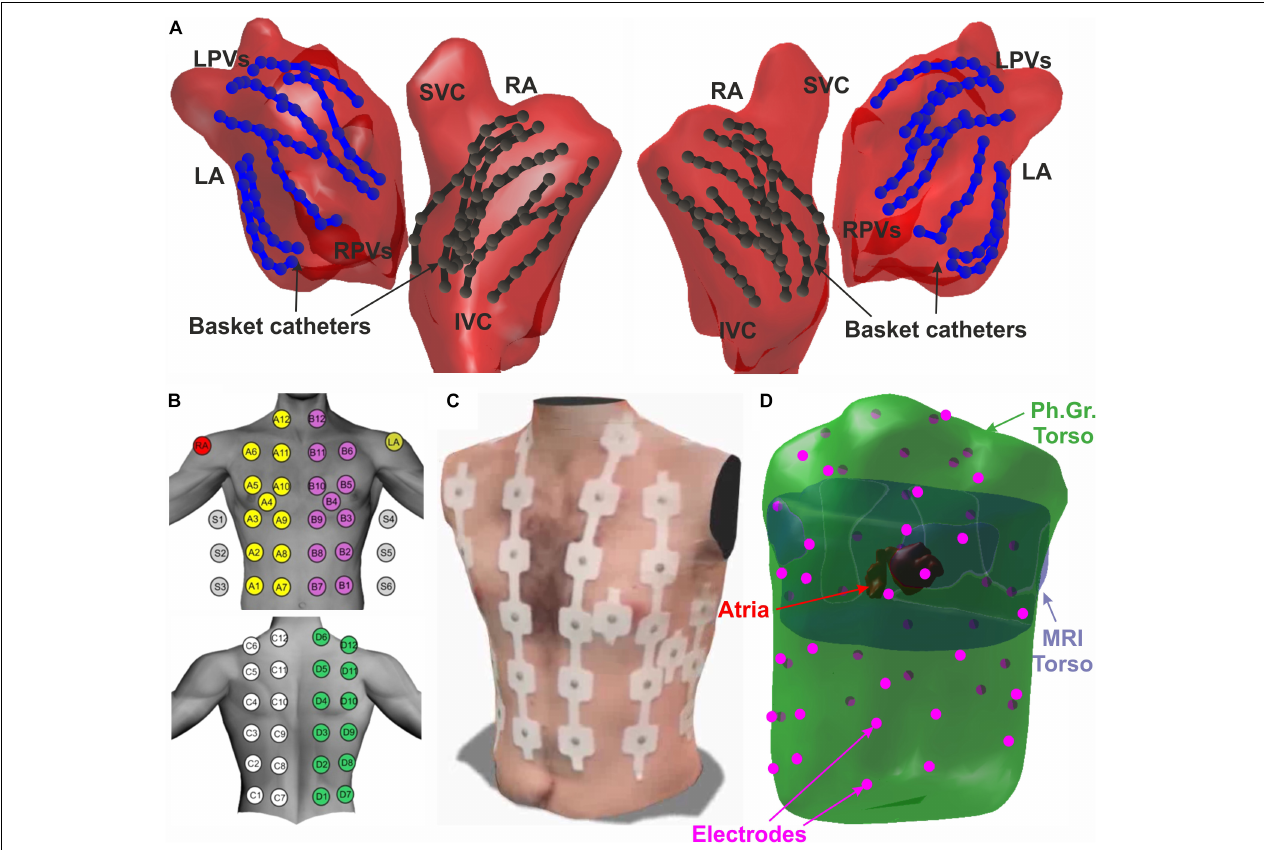
FIGURE 1 | Schematic view of the experiment set-up. (A) Atrial anatomy (red) with 2 basket catheters in left (blue) and right (black) atria. (B) Atrial anatomy segmentation from MRI scan. (C) Surface 57-ECG electrode distribution. (D) 3D meshes of the MRI torso (purple), photogrammetry torso (green), atrial anatomy (red), and BSPM electrodes